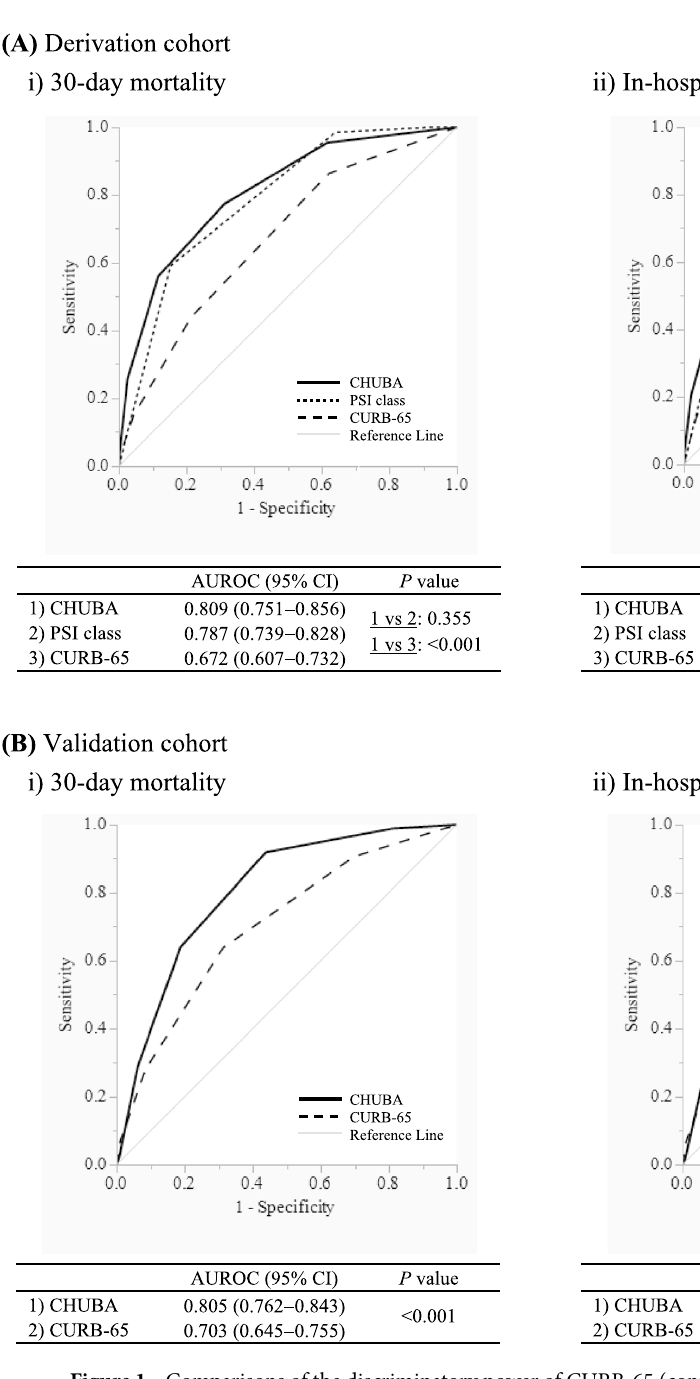
Figure 1. Comparisons of the discriminatory power of CURB-65 (confusion, urea, respiratory rate, blood pressure, age ≥ 65), pneumonia severity index (PSI) class, and CHUBA (confusion, hypoxemia, urea, bedridden, albumin) for predicting mortality among older patients hospitalized with a diagnosis of community-acquired pneumonia. ( A ) In the derivation cohort, the areas under the receiver operating characteristic (AUROCs) of CHUBA for prediction of both 30-day mortality and in-hospital mortality were significantly higher than those of CURB-65 (both P < 0.001) and were statistically equivalent to those of PSI class ( P = 0.355 and P = 0.343, respectively). ( B ) In the validation cohort, AUROCs of CHUBA for prediction of both 30-day mortality and in-hospital mortality were significantly higher than those of CURB-65 (both P <